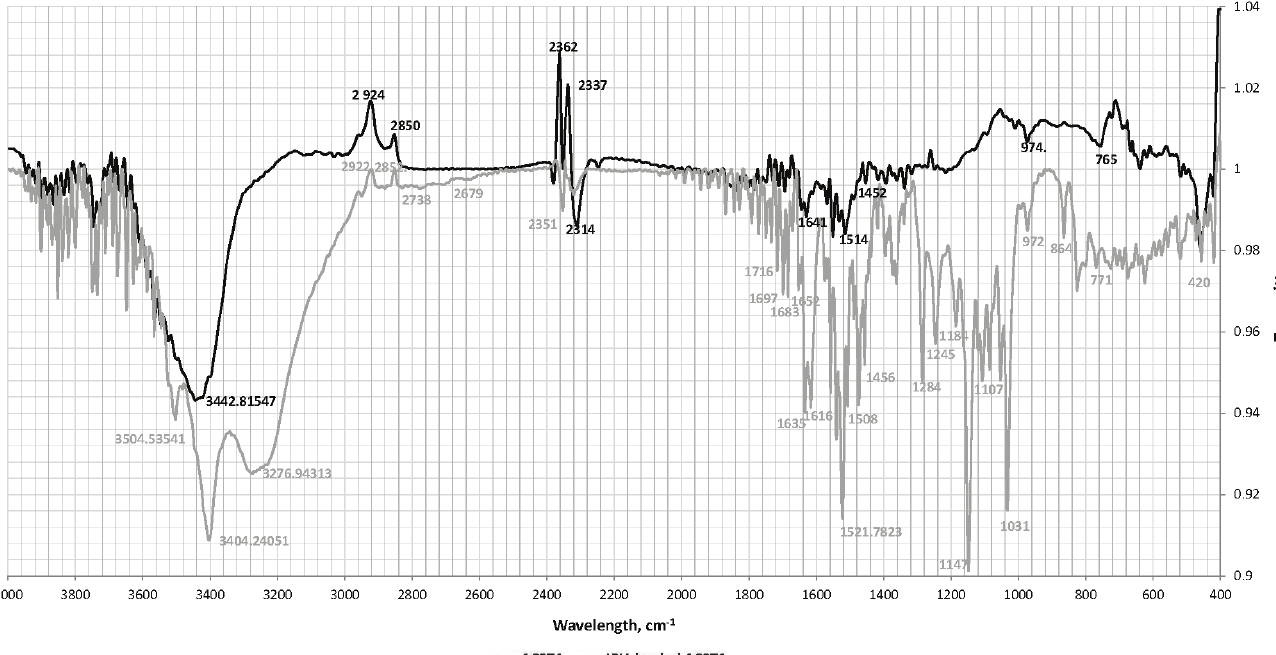
Fig. 4 – FTIR spectra of fresh and IBU-loaded